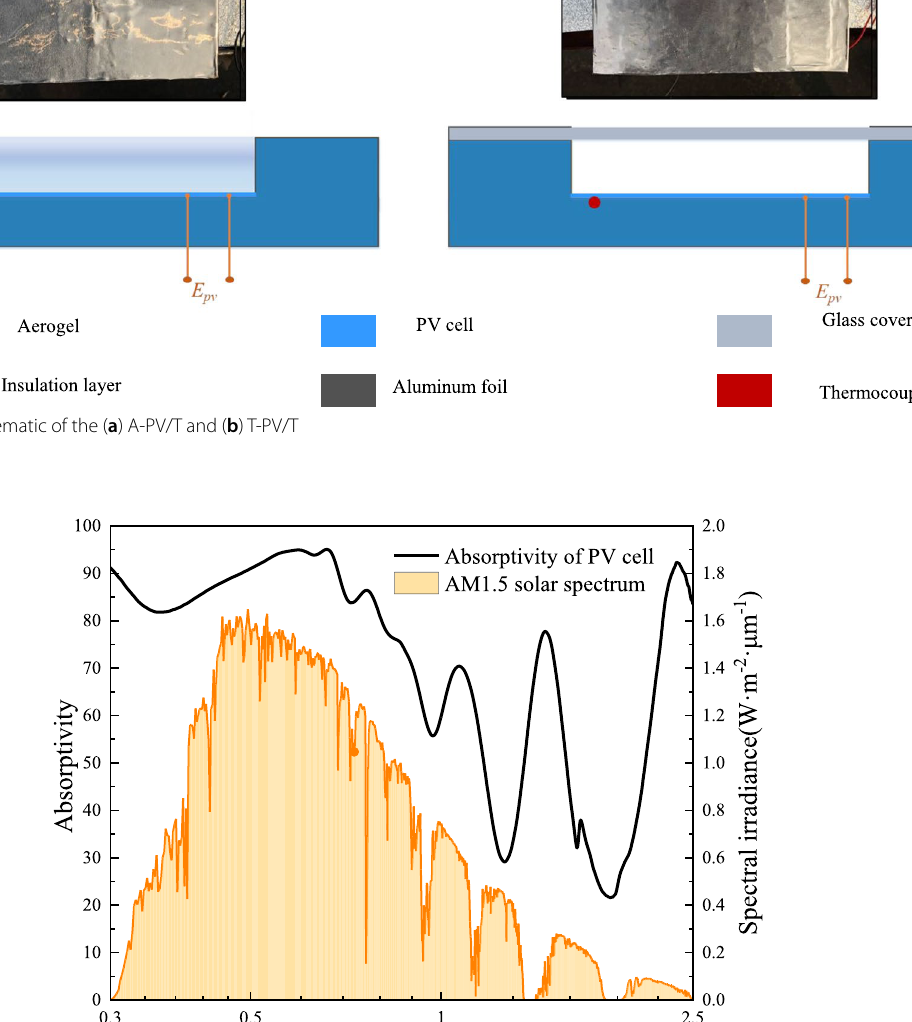
Fig. 3 Measured solar absorptivity curve of the encapsulated